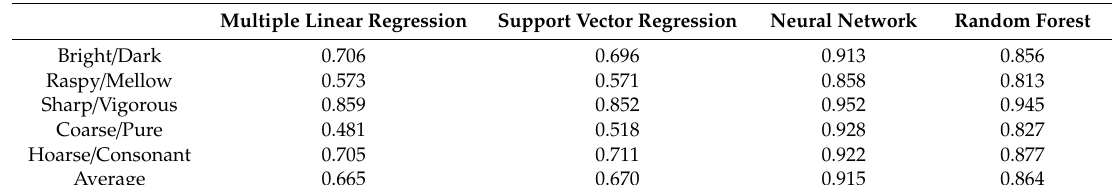
Table 7. A comparison of the accuracies achieved by four algorithms.